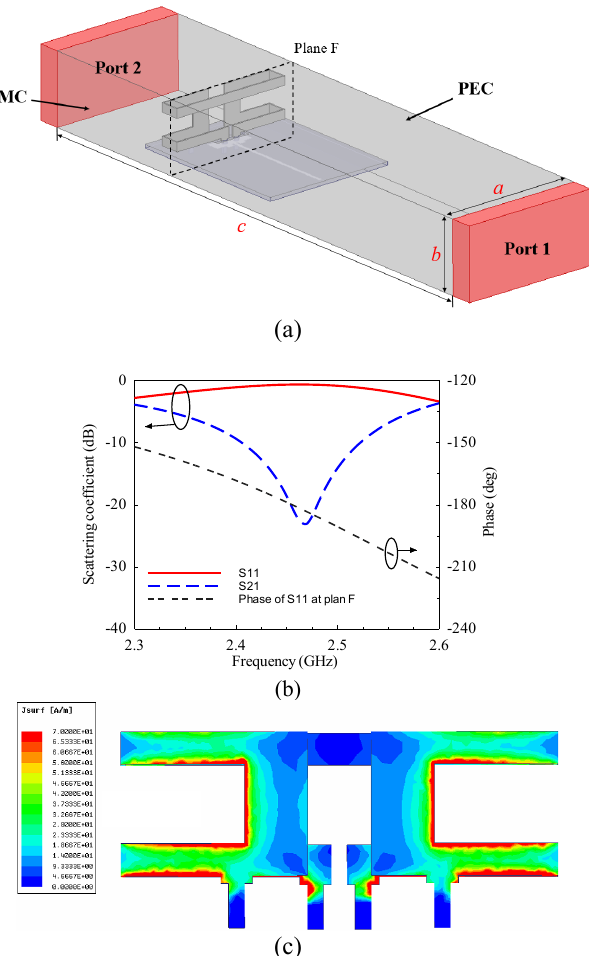
Figure 7: (a) RFSR in a rectangular tube in reflector mode simulation. a = 31 mm, b = 16 mm, c = 120 mm. (b) S- parameters of the proposed RFSR. (c) Induced current for RFSR operating in the reflector mode at 2.45